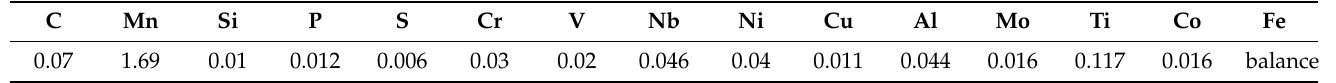
Table 1. Chemical composition of the base metal.